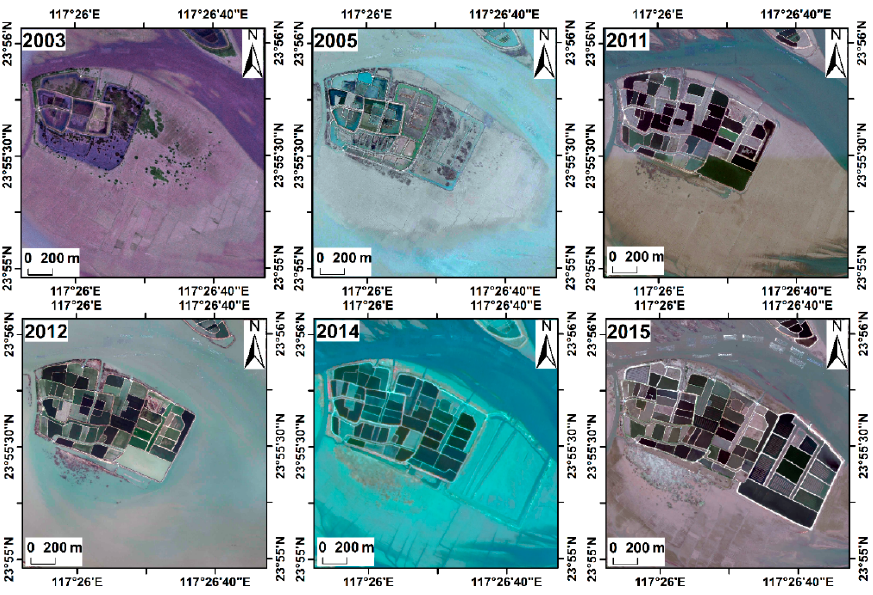
Figure 7. Images of S. alterniflora shrinkage caused by land reclamation from 2003 to 2015.